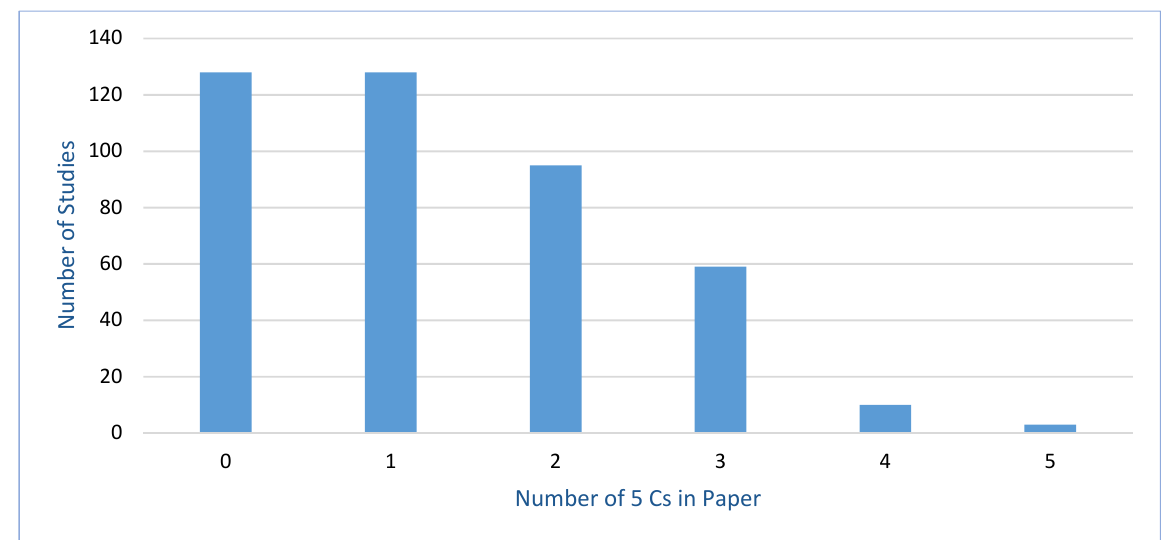
Figure 5. Number of Studies with Multiple 5 C